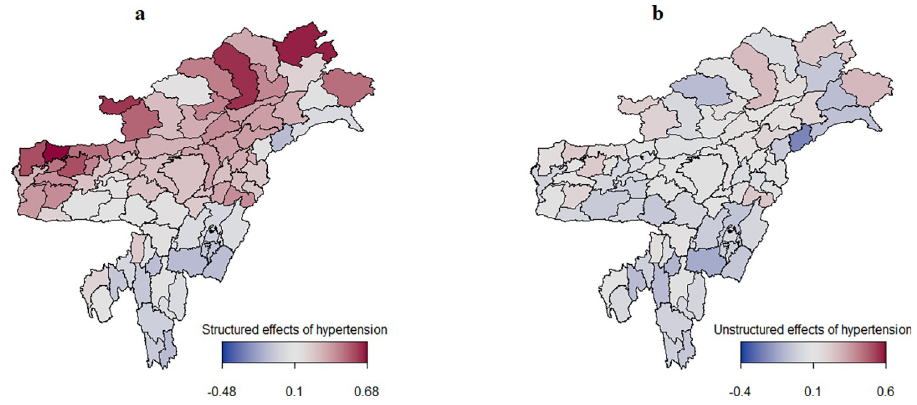
Fig 6. Estimated posterior means of the structured spatial effects (left) and the unstructured spatial effects (right) on the log-odds of hypertension.